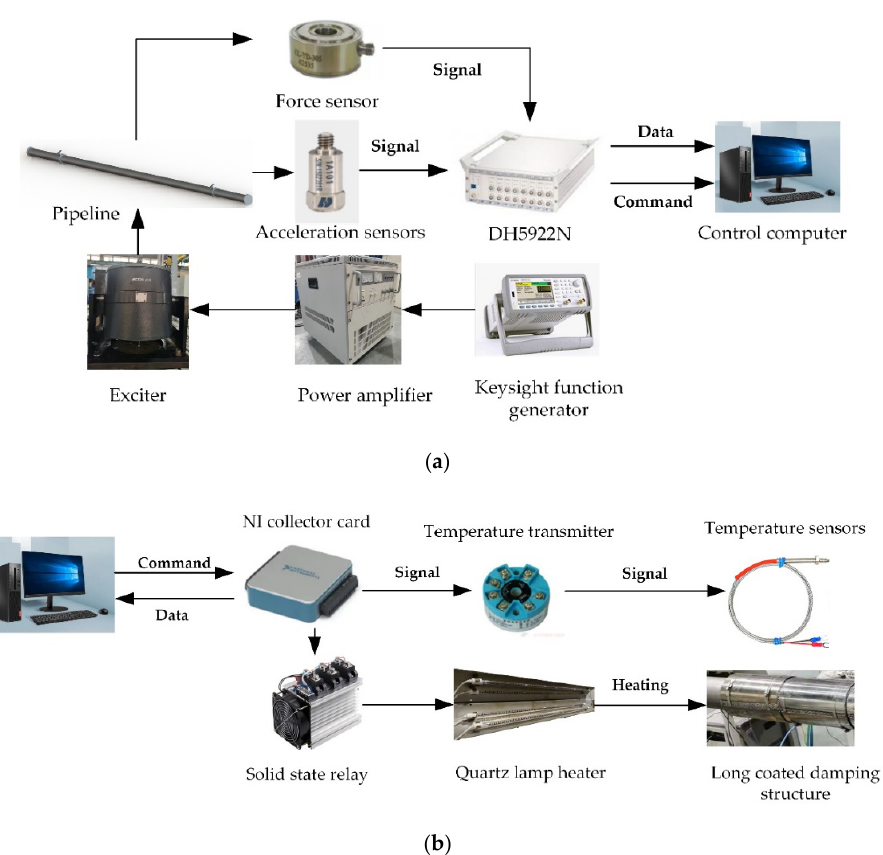
Figure 6. Block diagram of the thermal–vibration joint test system: ( a ) vibration excitation test system; ( b ) thermal environment simulation test system.